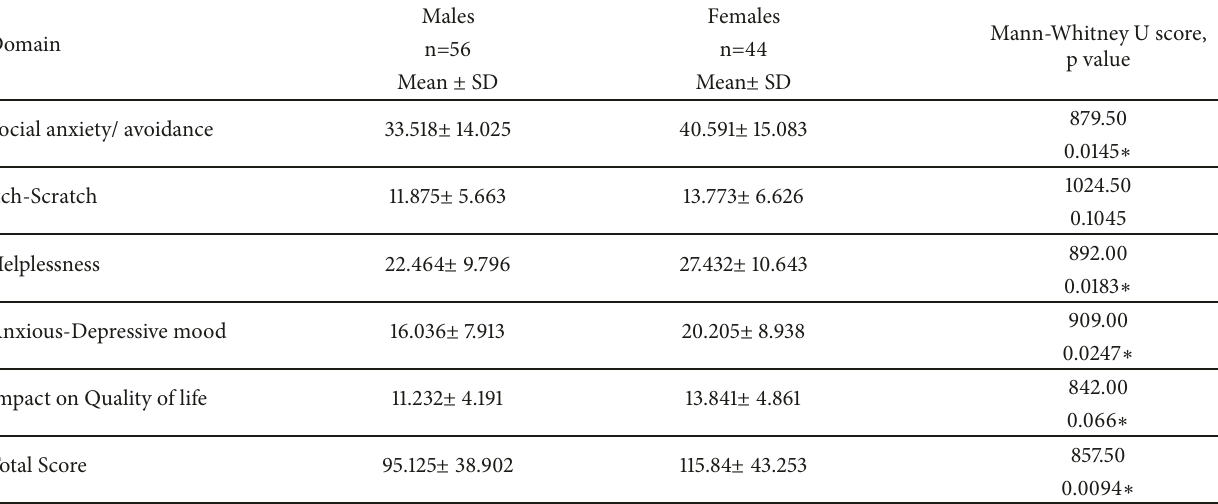
Table 4: Gender differences for coping as per